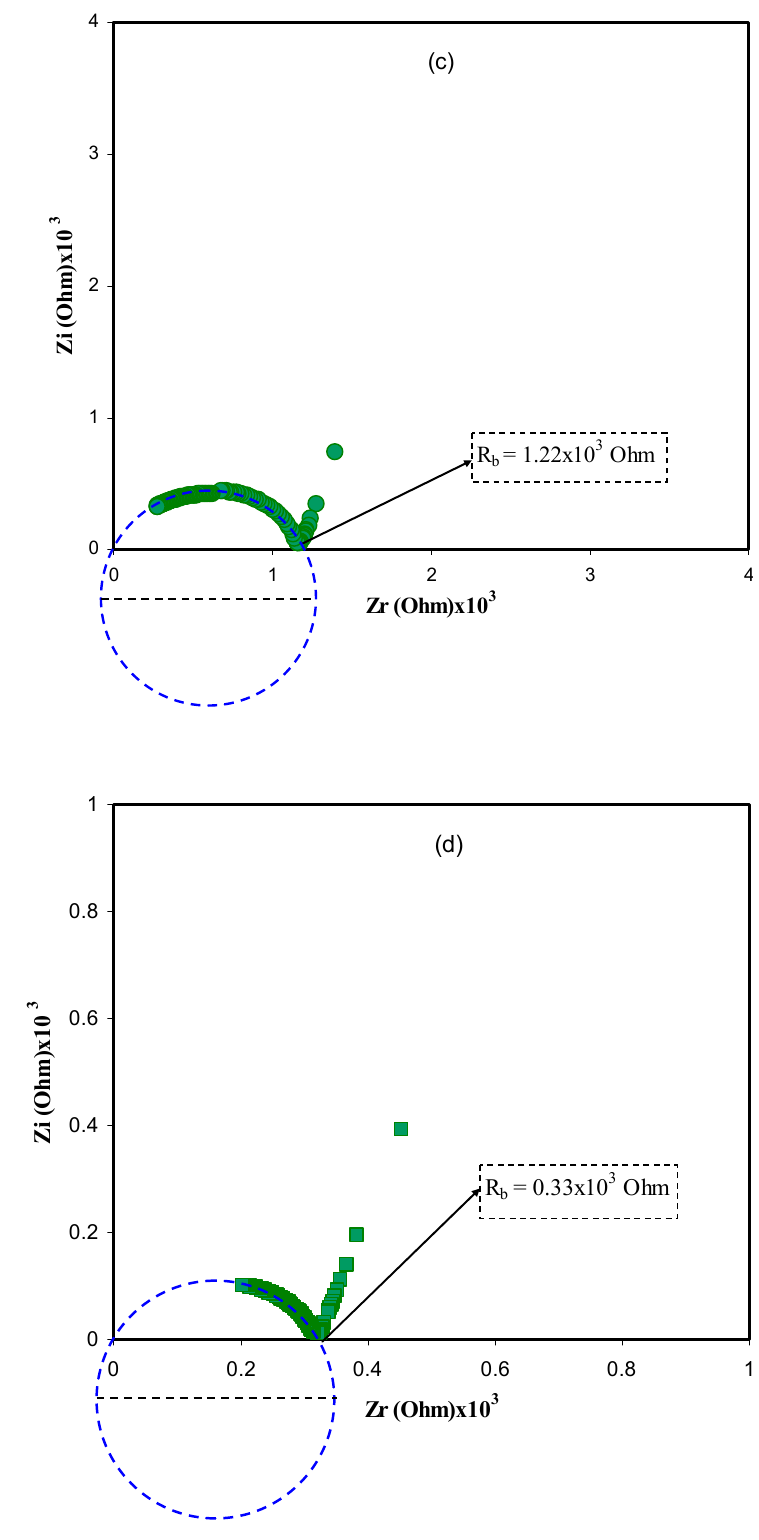
Figure 1. Complex impedance plot of PVA:LiFC 3 SO 3 ( Z ivs Z r) solid electrolyte at ( a ) 303 K, ( b ) 323 K ( c ) 343 K, and ( d ) 353 K. The insets indicate the corresponding bulk resistance R b . Clearly from 303 K to 353 K the diameter of the semicircles in impedance plots decreases and the spike regions were increased.